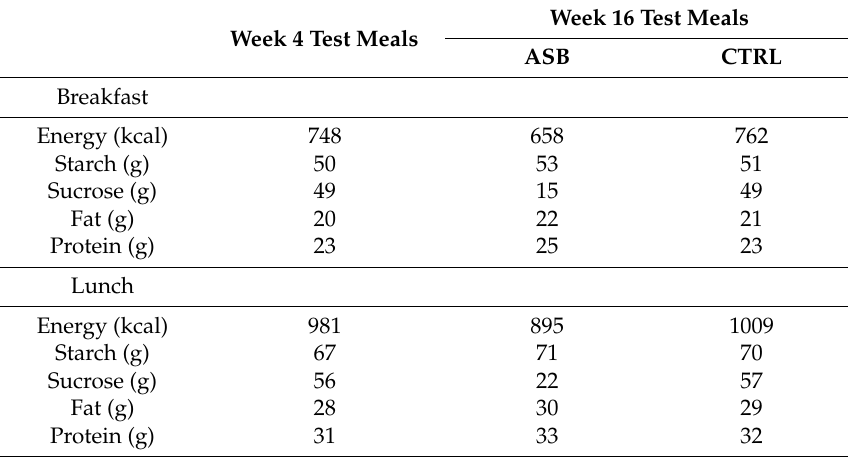
Table 1. Nutrient content of the test